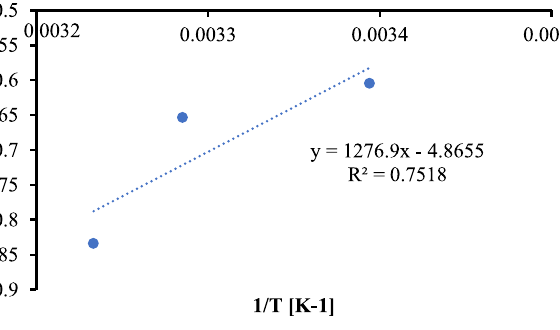
Fig. 4. A plot of ln( m m ) vs. 1/ T .